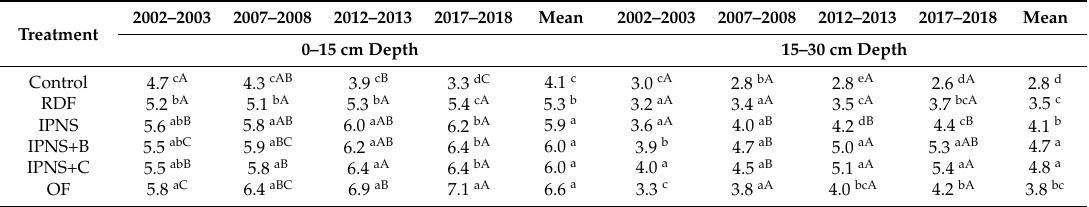
Table 5. Effects of different nutrient management options on the soil organic carbon (SOC) content (g kg − 1 ) at soil depths of 0–15 and 15–30 cm after 5 RWS cycle intervals.